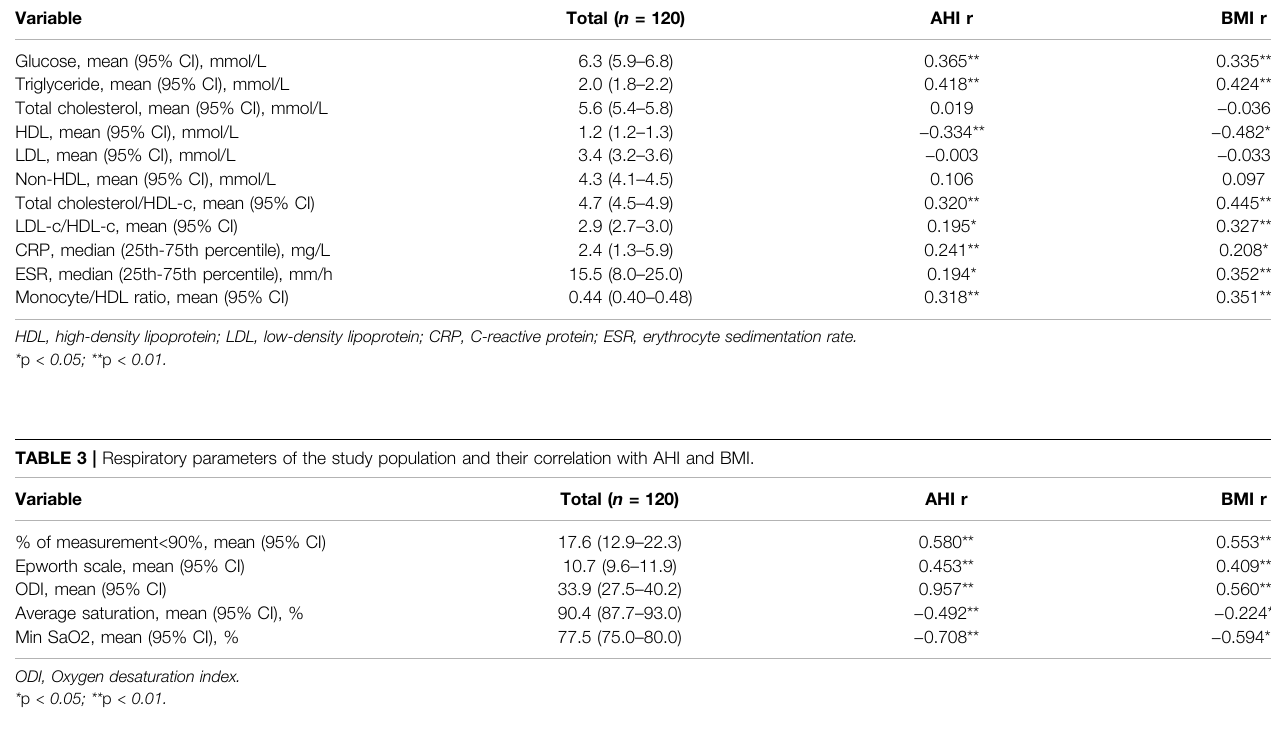
TABLE 2 | Glucose, lipids and in fl ammation parameters of the study population and their correlation with AHI and BMI.